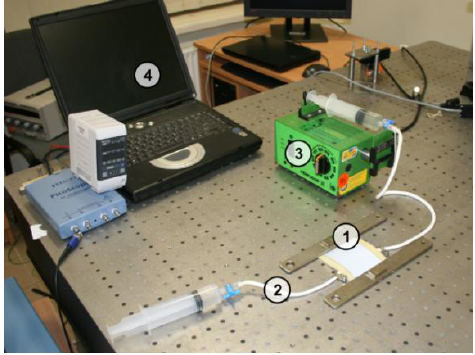
Figure 11. Experimental setup for registration of artificial radial pulses: (1) measurement location (test point); (2) vascular graft; (3) flow speed controller; (4) data registration and presentation.